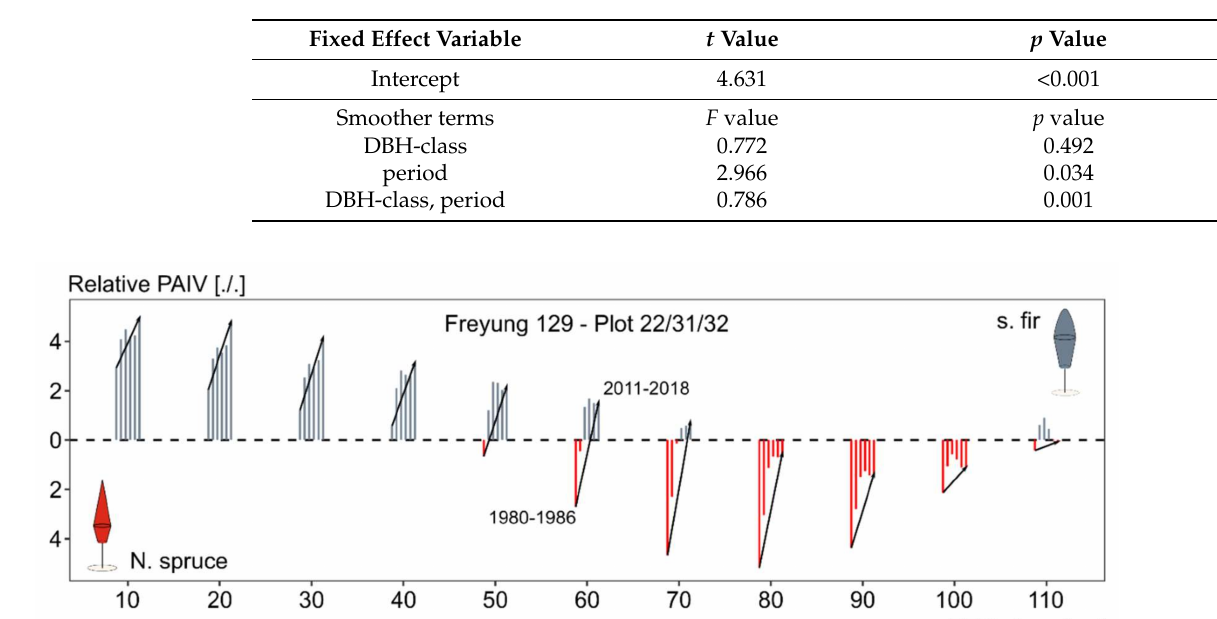
Table 6. Results of fitting the generalized additive model from Equation (9) to the data of the subplots FRY 129/22, 31, and 32.